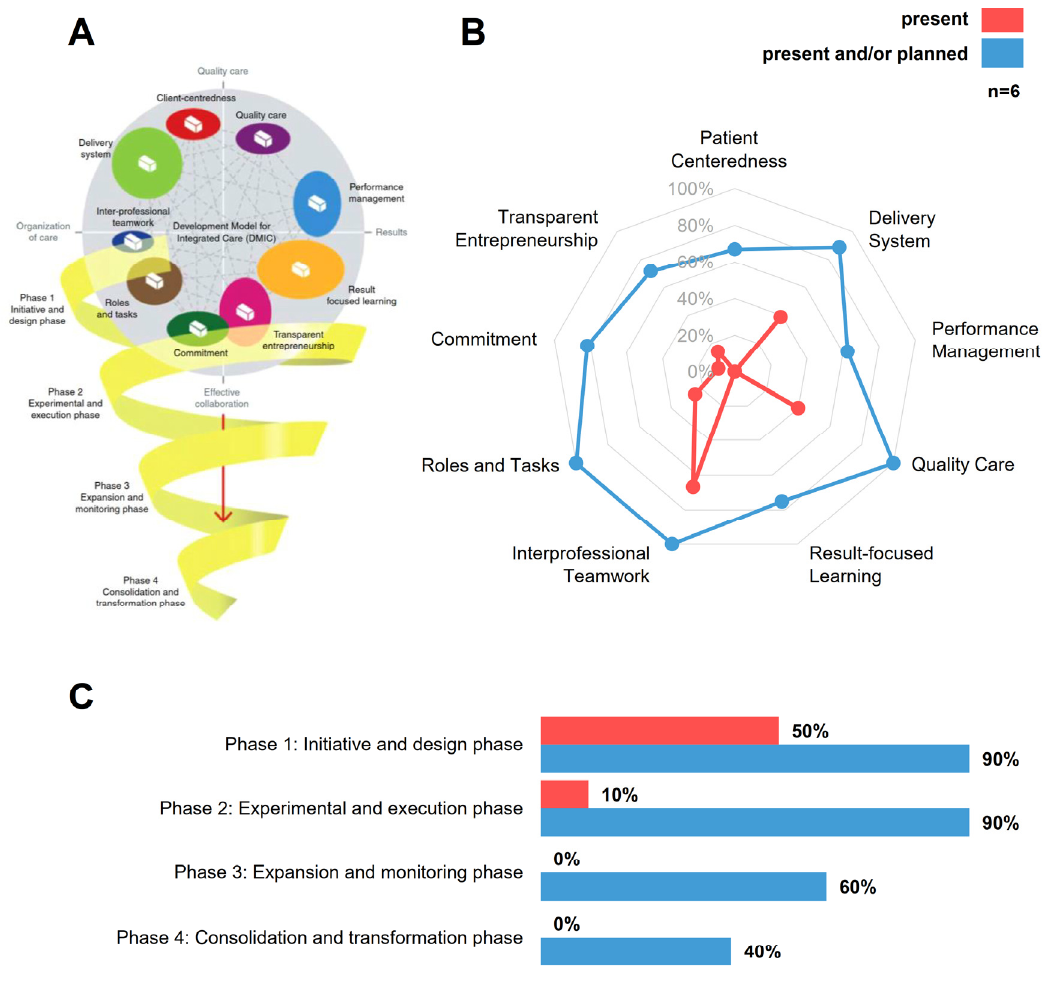
Figure 7. Assessment of PANOS according to the Development Model for Integrated Care (DMIC) framework ( A ): Illustrative summary of the Developmental Model of Integrated Care (DMIC). A total of 89 components relevant to ICC implementation are grouped into 9 clusters and located on a cluster map with 4 axes (Organization of care, Quality care, Results and Effective collaboration). The model also considers 4 developmental stages ranging from phase 1—initiative and design phase, to phase 4—consolidation and transformation phase. ( B ): Current assessment of PANOS by 6 involved key representatives according to which elements already have been achieved (rated as “present”, shown in red) and how PANOS would represent the model if planned activities are implemented (rated as “planned or present”, shown in blue). ( C ): PANOS is still in an early maturation state. Achieved elements belong to phase 1 and 2; the percentage of relevant elements already planned but not yet achieved is much higher for phases 1 and 2 (90% each) than for phase 3 (60%) and phase 4 (40%). Reproduced with permission from Mirella Minkman, Journal of Integrated Care; published by Emerald Publishing Pty Limited, 2016.